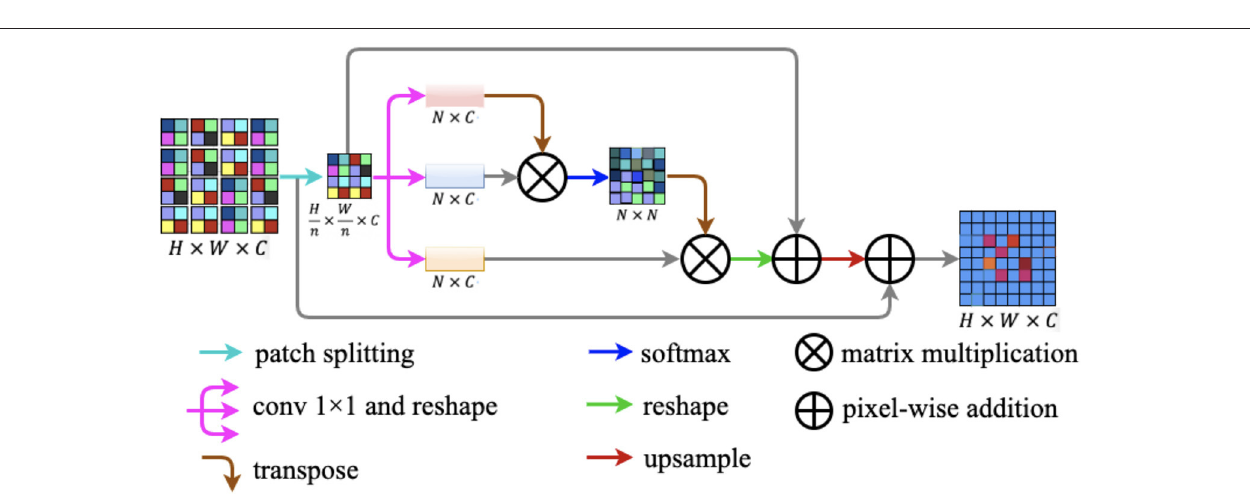
utilized the relations between each patch of the feature map to replace the relations between the positions of each pixel. For an input feature map F ∈ R H × W × C , we fed F into the patch-splitting module where F will be split into non-overlapping patches.